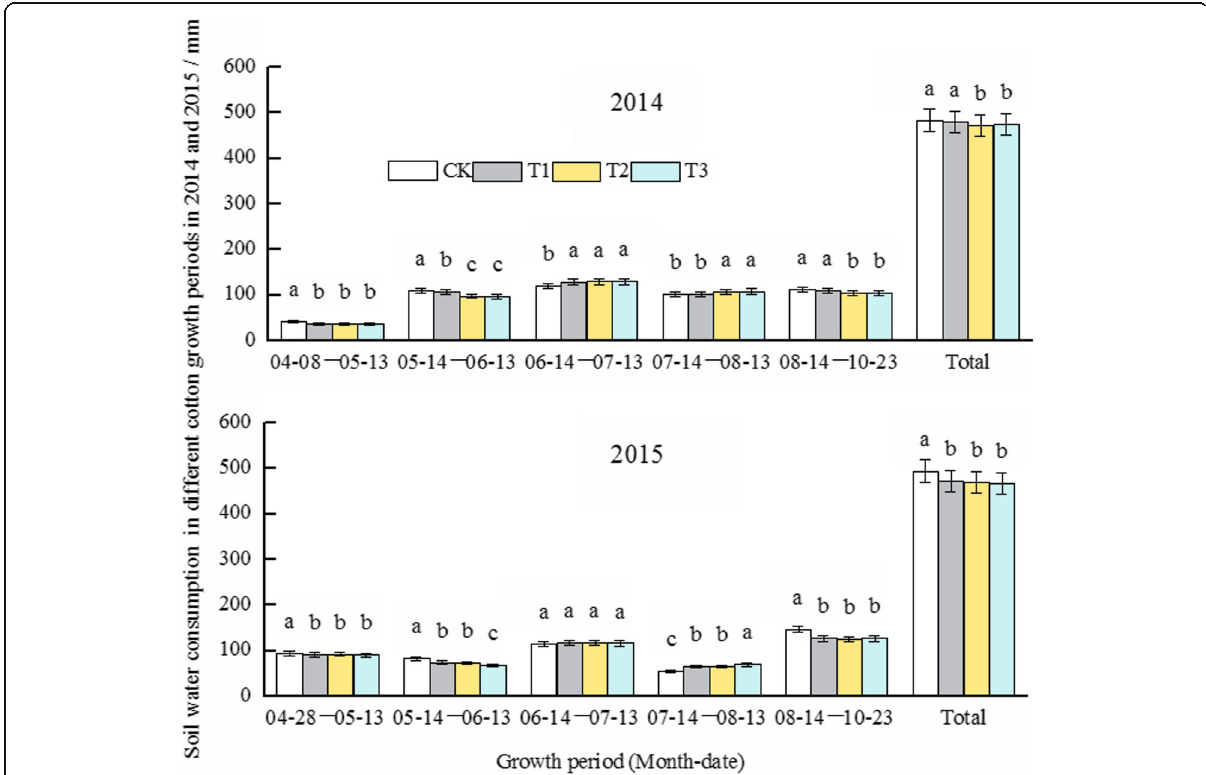
Fig. 4 Changes in soil water consumption during different cotton growth stages in 2014 and